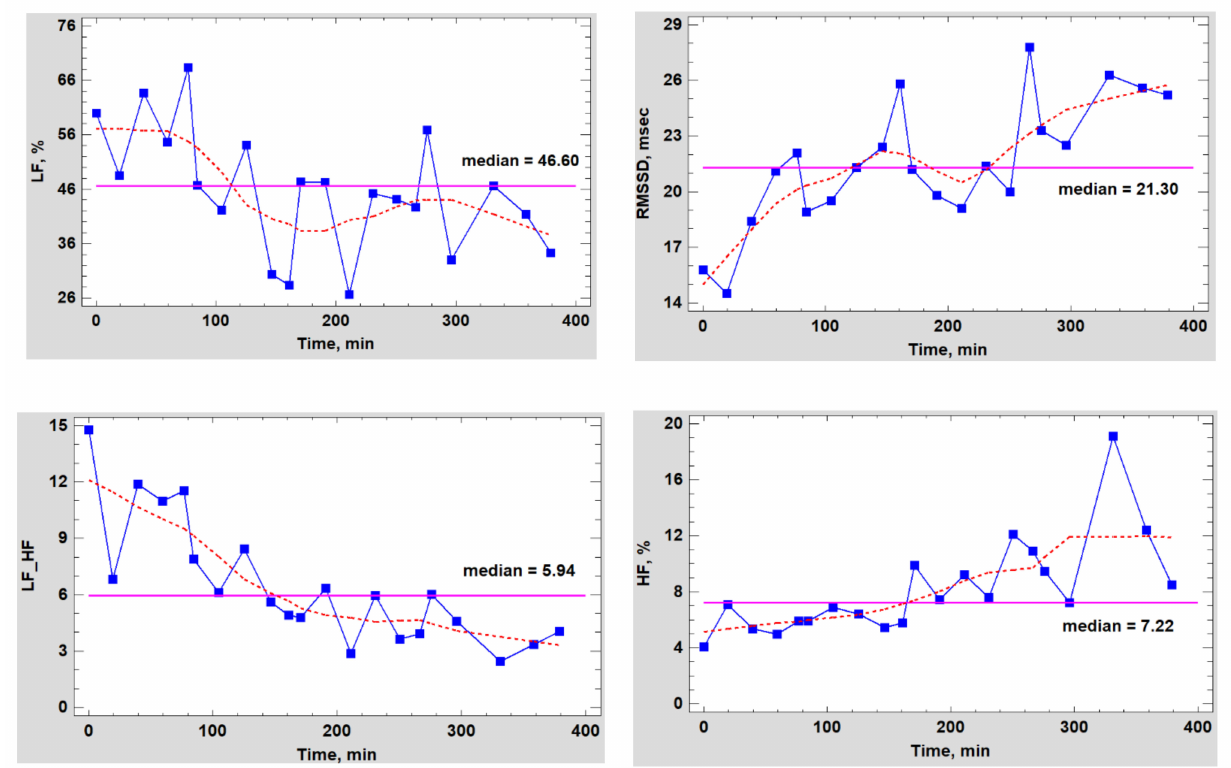
Figure 5. Dynamics of HRV indicators in a volunteer during the testing period for nicotine- free